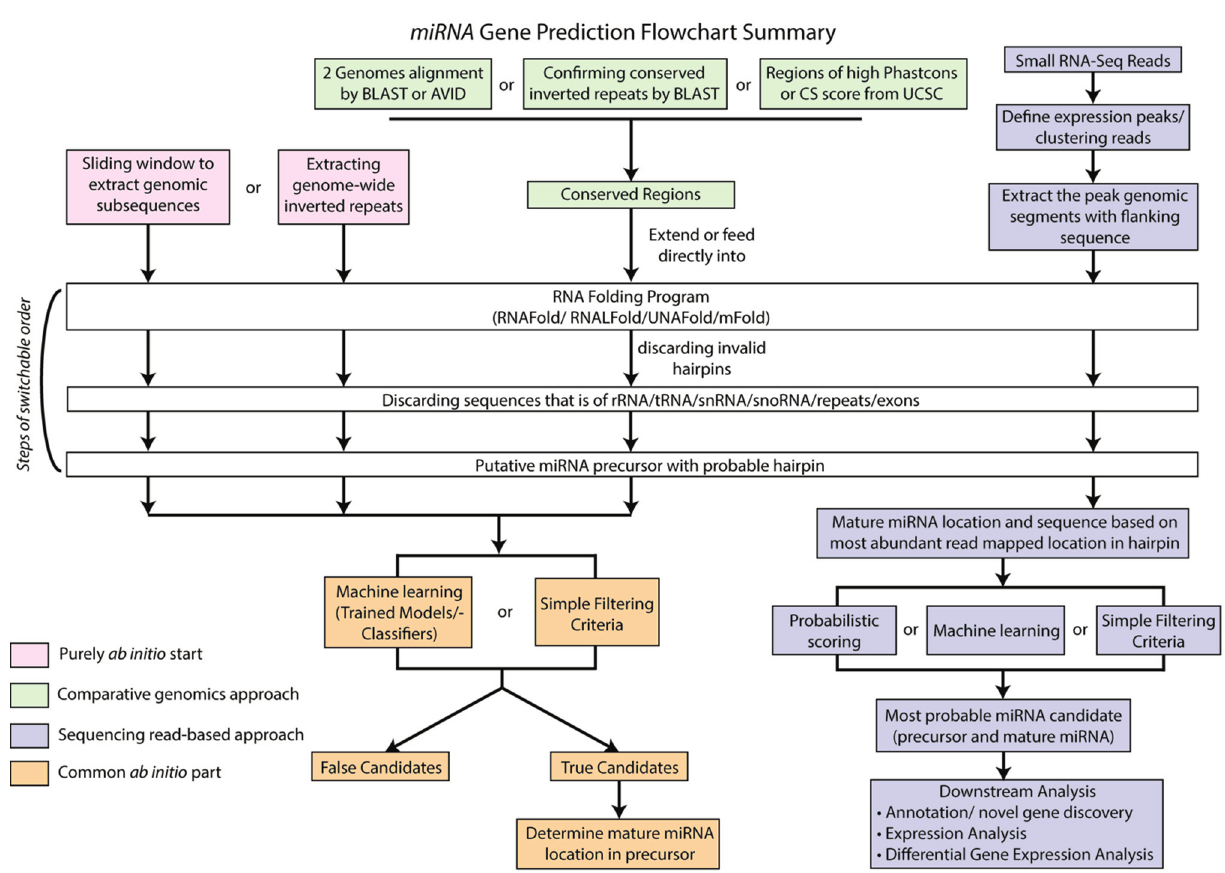
Figure 4. A flowchart for miRNA gene prediction. This flowchart summarized how computational tools predict miRNAs with different approaches. Purely ab initio miRNA prediction programs (pink boxes) use the reference genome of interest as the only starting material to generate miRNA precursor candidates, followed by classifying/filtering with known miRNA properties. In contrast, comparative genomics miRNA prediction programs (green boxes) start with identifying conserved regions between two or more genomes to generate miRNA precursor candidates, followed by the same classifying/filtering step of purely ab initio prediction programs (orange boxes). The sequencing read-based prediction programs (purple boxes) use miRNA expression data to locate possible mature